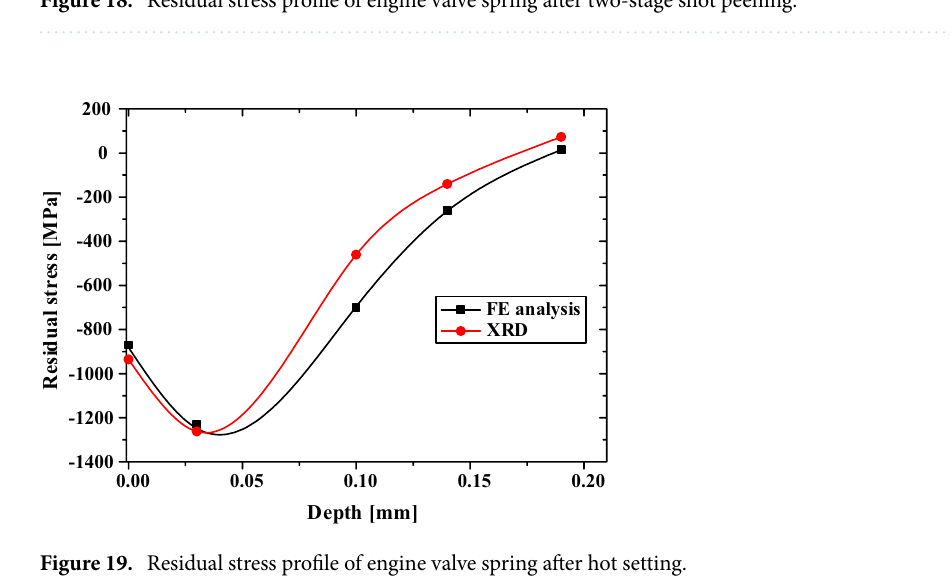
Figure 18. Residual stress profile of engine valve spring after two-stage shot peening.